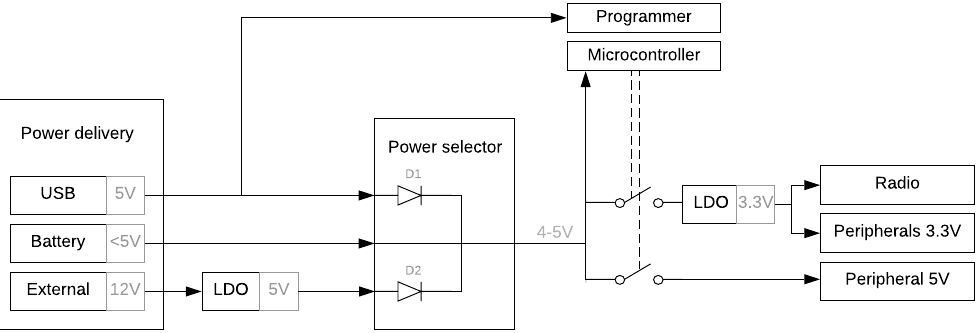
Figure 3. Power flow of the proposed solution: power can be delivered through the USB port, an external battery, or an external 12 V supply. The most efficient power rail is selected to power the MCU and other peripherals. The programmer is only activated when the USB port is active. The on-board radio and other peripherals can be turned off in sleep